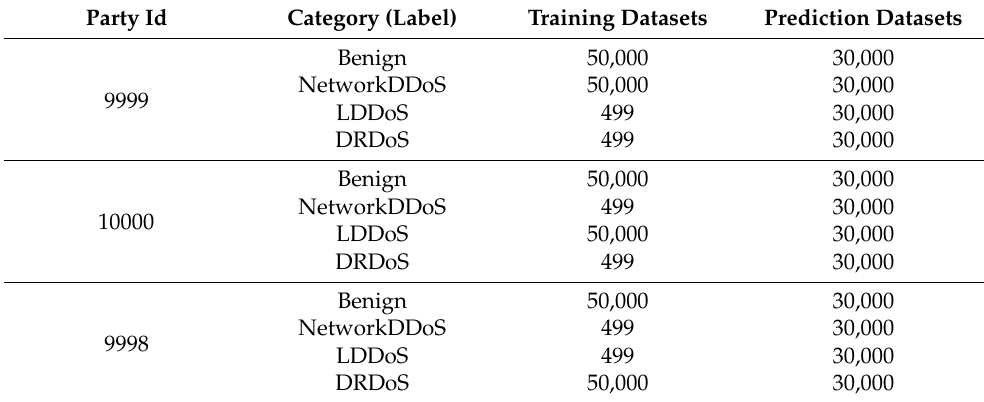
Table 6. Federated learning dataset of all parties at γ = 1%.